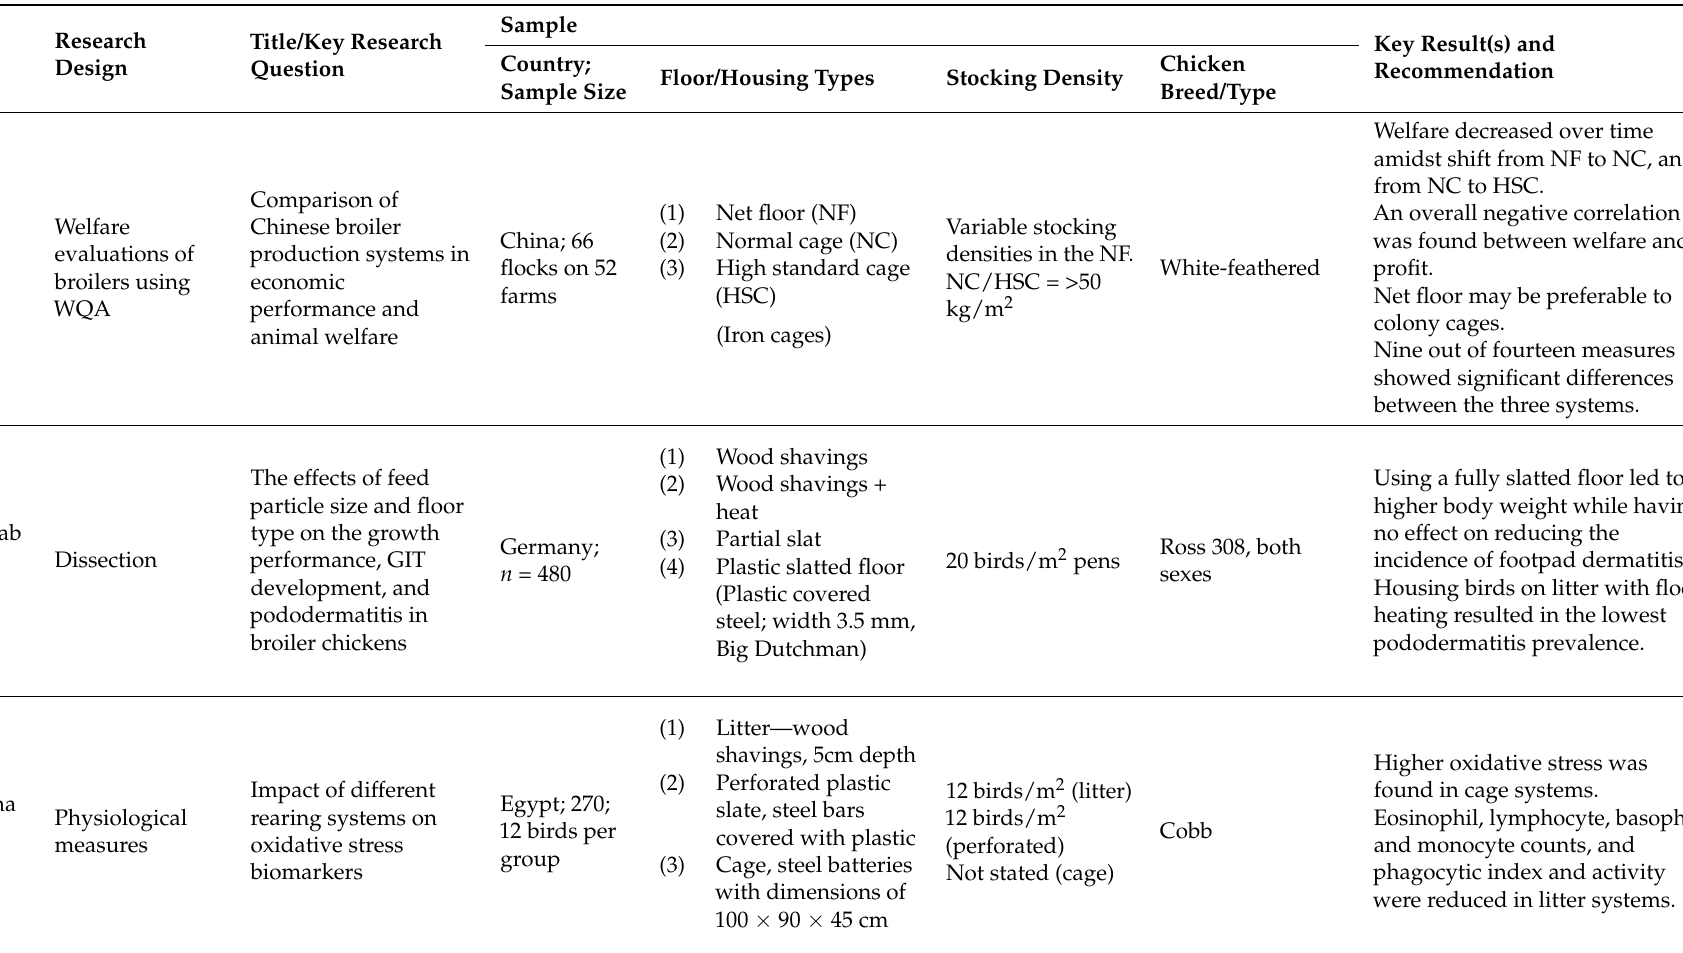
Table 1. Studies (15) suggesting at least some form of welfare problem using slatted floors or cages. Nb: If the material of the slatted floor was not stated, it was not reported. Stocking densities were not converted into consistent measures due to variable chicken body weights. WQA refers to Welfare Quality Assessment. Studies are sorted by publication